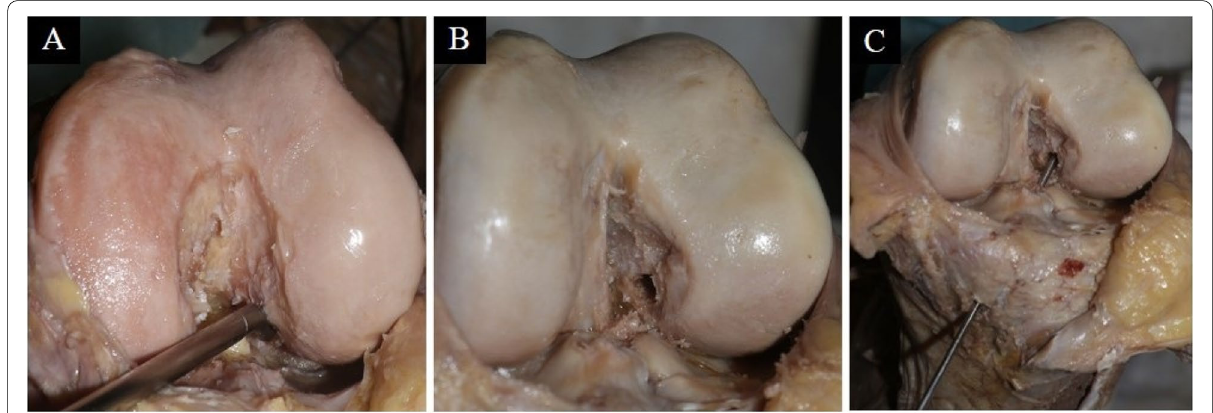
Fig. 1 Femoral tunnel confection. A. Femoral tunnel performed by anteromedial portal. B. Femoral tunnel already performed. C. Matching of tibial tunnel with femoral tunnel (non-anatomical